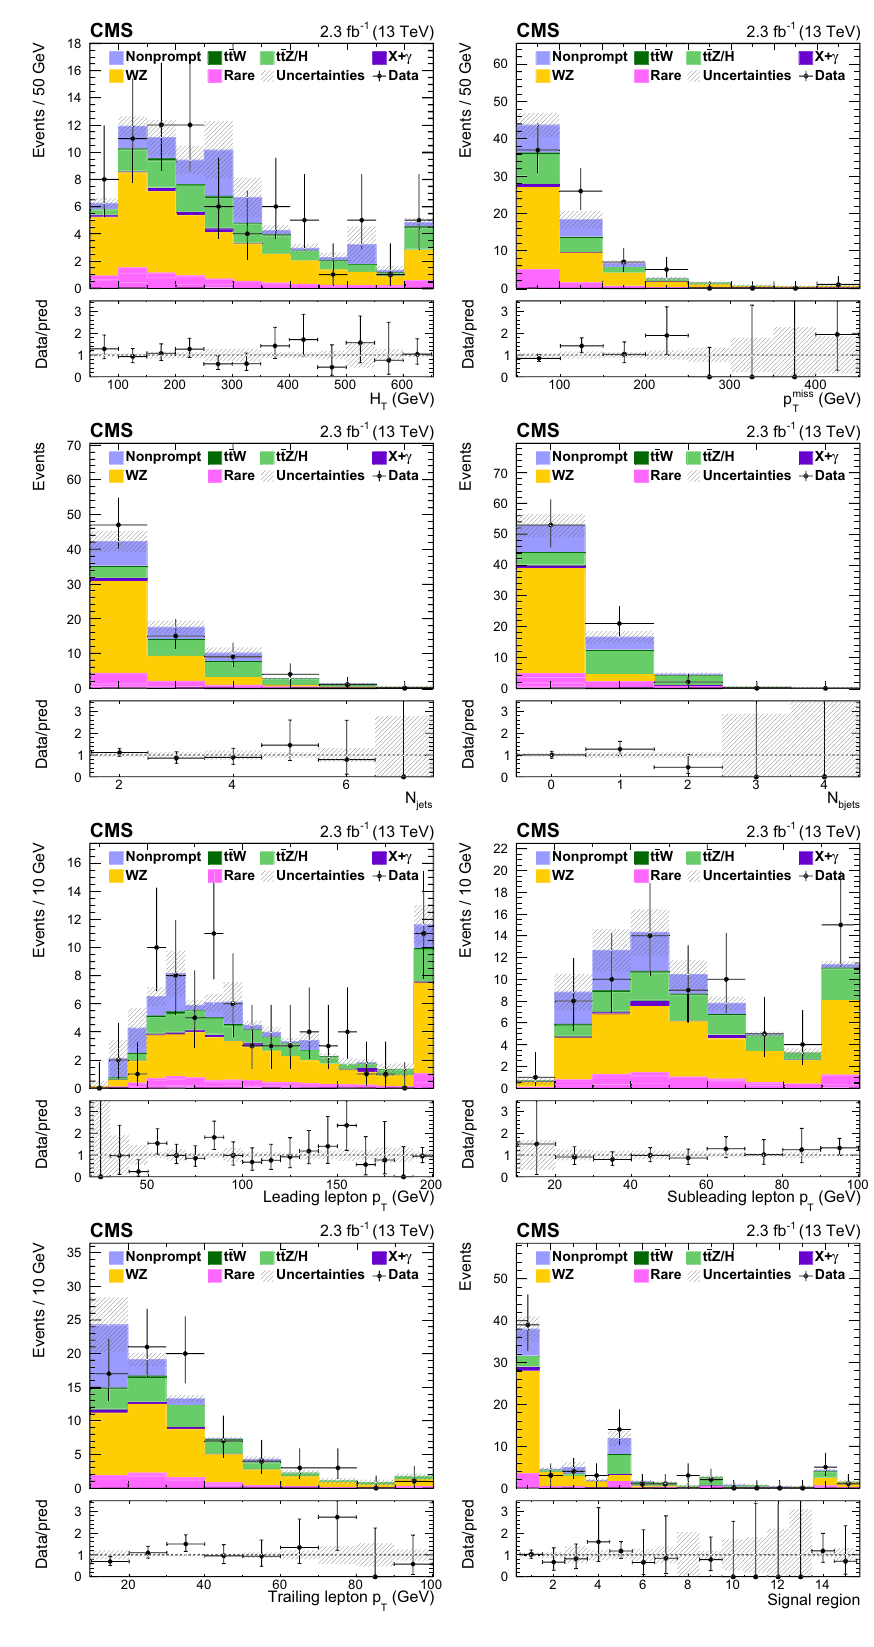
Fig. 3 On-Z samples: from left to right, top to bottom, distributions of H T , p miss , N j , T N b , p T of leptons for the predicted backgrounds and for the data in the on-Z baseline selection region, in these plots the rightmost bin contains the overflow from counts outside the range of the plot. On the bottom-right corner the total predicted background and the number of events observed in the 15 on-Z SRs is